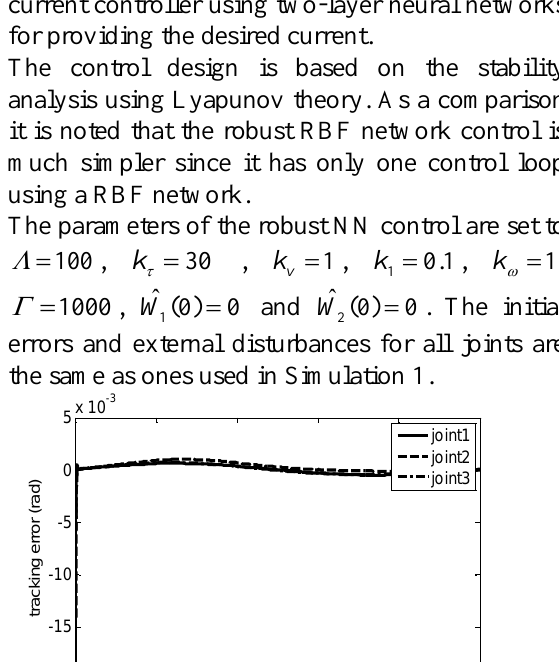
Figure 2. The desired joint trajectory.